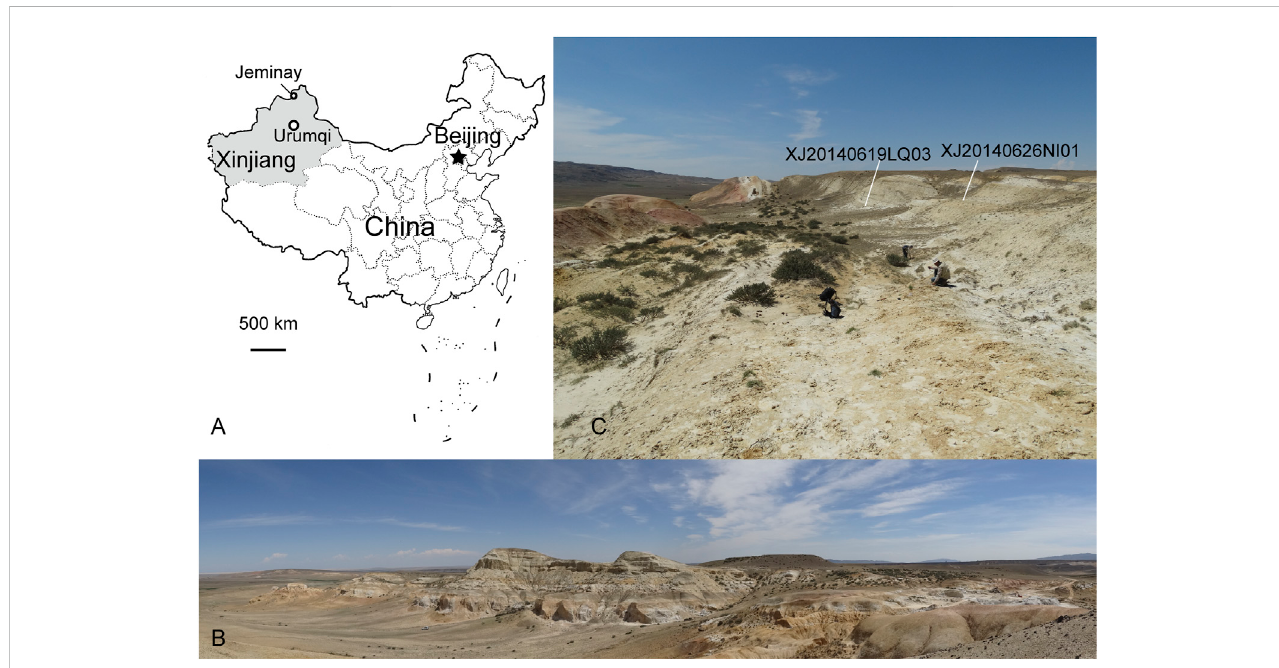
FIGURE 1 Late Eocene sciurid sites in Jeminay, northwestern Xinjiang, China. (A) Map showing the fossil sites located at Jeminay, Xijiang Uygur Autonomous Region, northwestern China; (B) panoramic view of the fossiliferous pro fi le of the Keziletuogayi Formation that produced the additional material of fossil squirrels (photo taken by the fi rst author QL on 20 June 2014); (C) a close-up view of the stratigraphy yielding the fossil